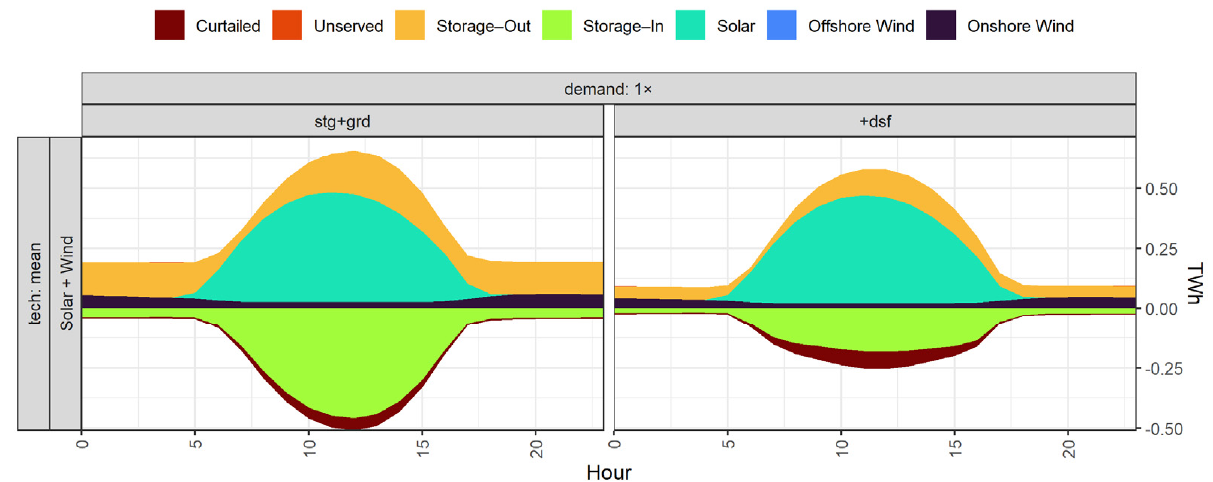
Figure 8. Annual average power generation and storage operation profiles by hours for selected scenarios.